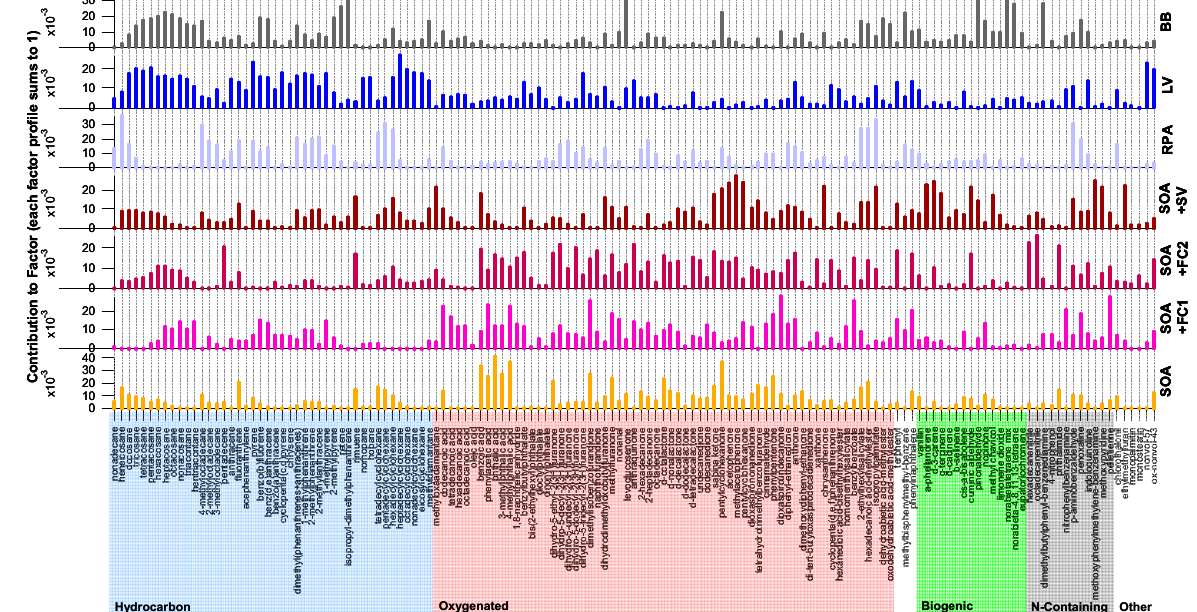
Fig. 7. Fall PMF profiles. Compounds are generally grouped by hydrocarbons (compound names with blue background), oxygenated species (red background), biogenics (green background), nitrogen-containing compounds (grey background), and others (white background), respectively. Total compound contributions to each of the 7 factor profiles sums to a value of